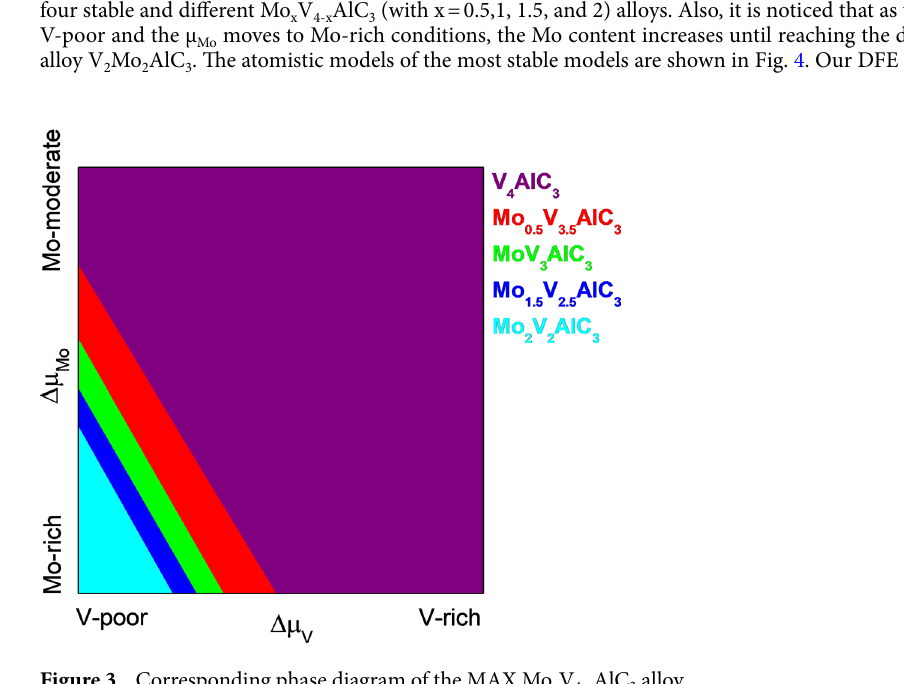
Figure 3. Corresponding phase diagram of the MAX Mo x V 4-x AlC 3 alloy.